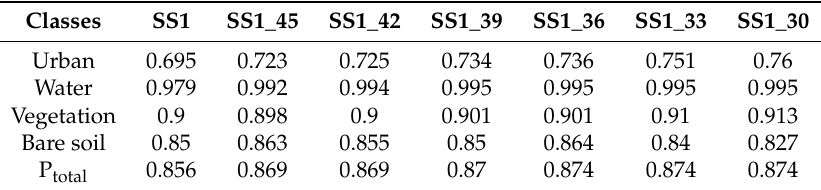
Table 29. Probabilities of correct classification depending on compressed image quality for Set 1, ADCTC, ML classifier.